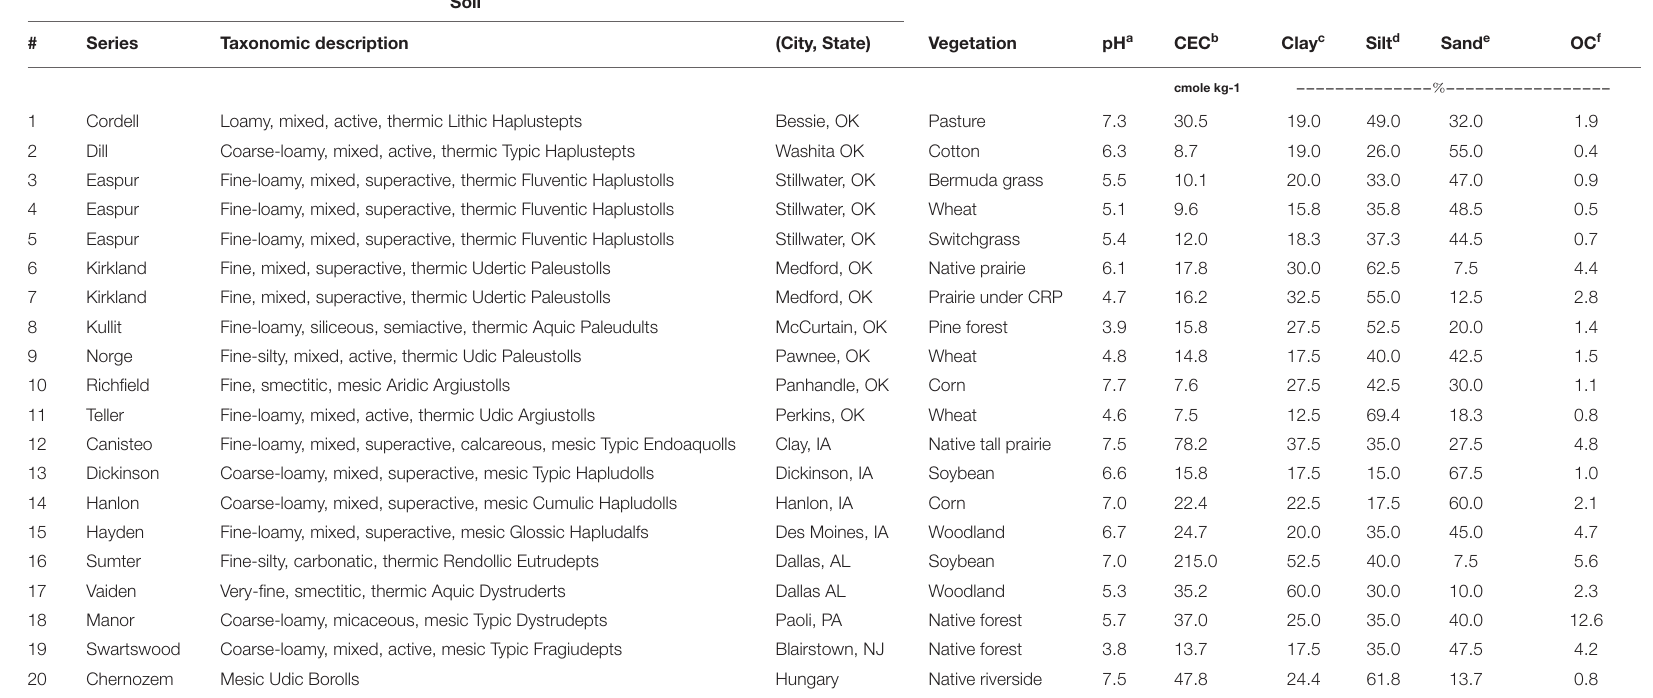
TABLE 1 | The taxonomy, location, vegetative cover, and key physical and chemical properties of the 20 soils used in this study.